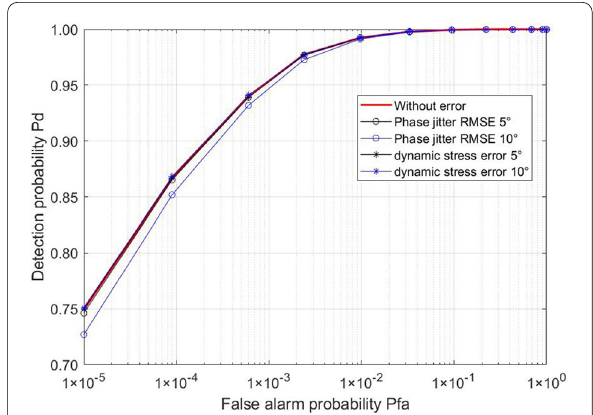
Fig. 12 ROC performance ( C (cid:31) N 0